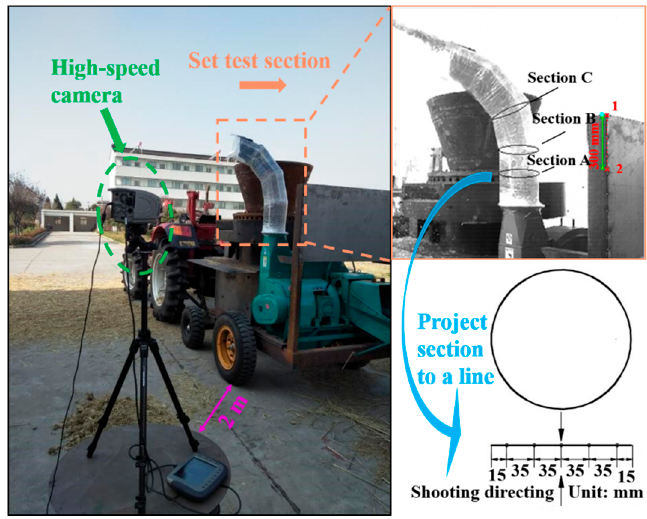
Figure 5. High-speed photography test process.